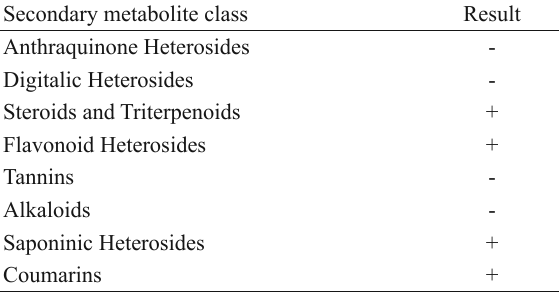
Main classes of secondary metabolites found in rhizophore samples of Chrysolaena simplex